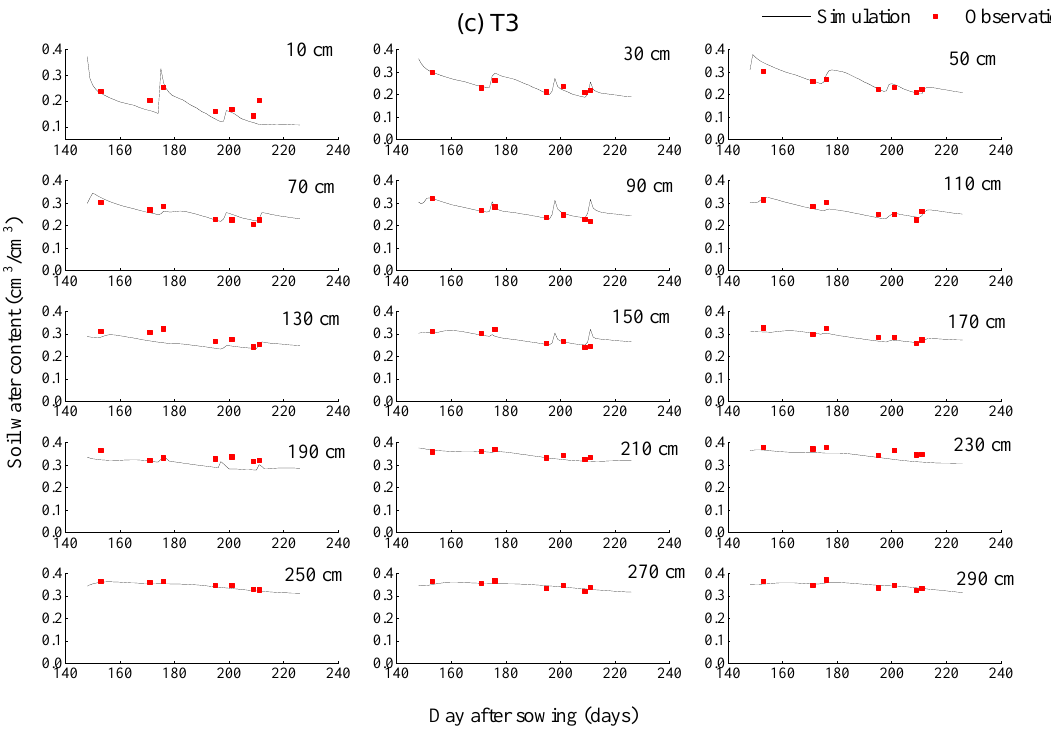
Figure 4. The comparison of the calculated and measured soil water dynamics of winter wheat during irrigation at different soil depths. ( a ) T1 treatment; ( b ) T2 treatment; ( c ) T3 treatment.